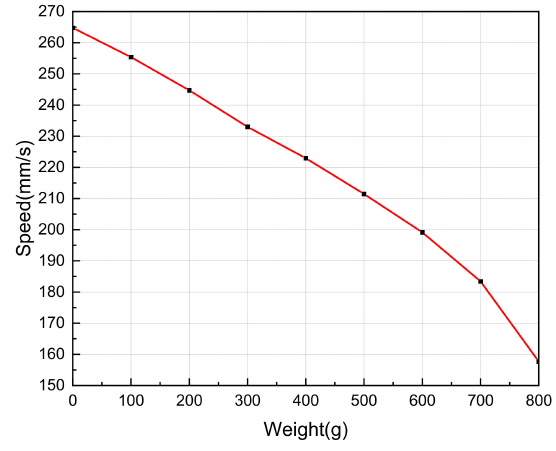
Figure 10. Relationship between weight and speed.